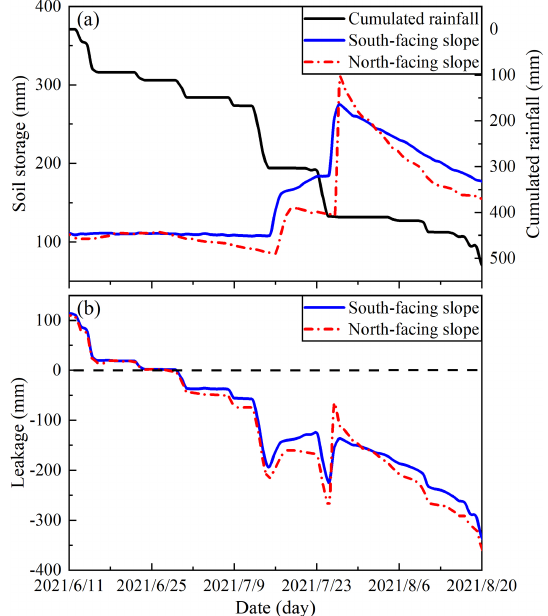
Figure 10. Seepage model of slope water storage and drainage. (a) Soil water storage. (b) Soil water